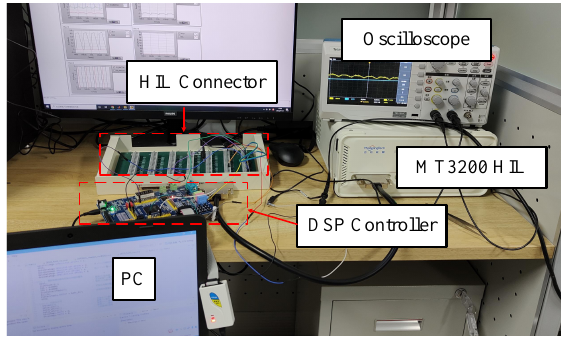
Figure 8. SimStar MT3200 HIL experimental platform.